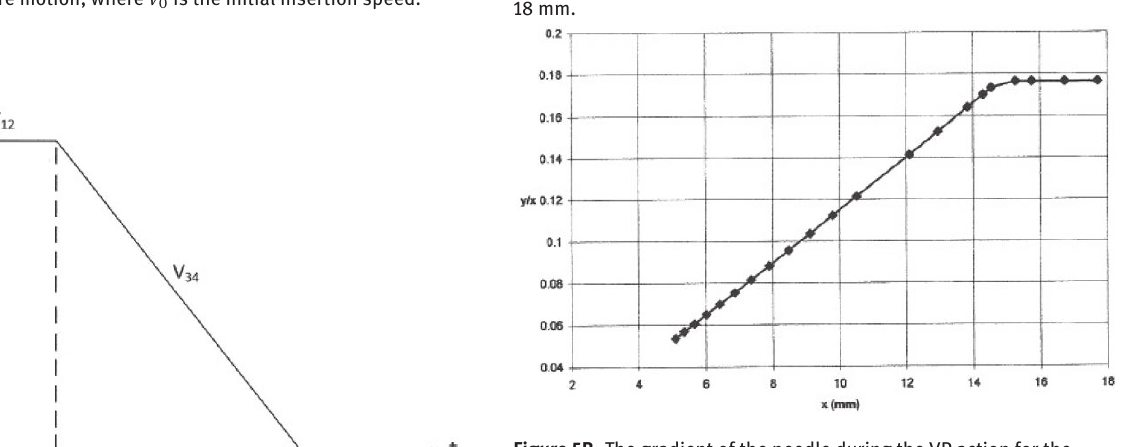
Figure 3: A typical velocity profile of the needle during the venepuncture motion, where v 0 is the initial insertion speed.